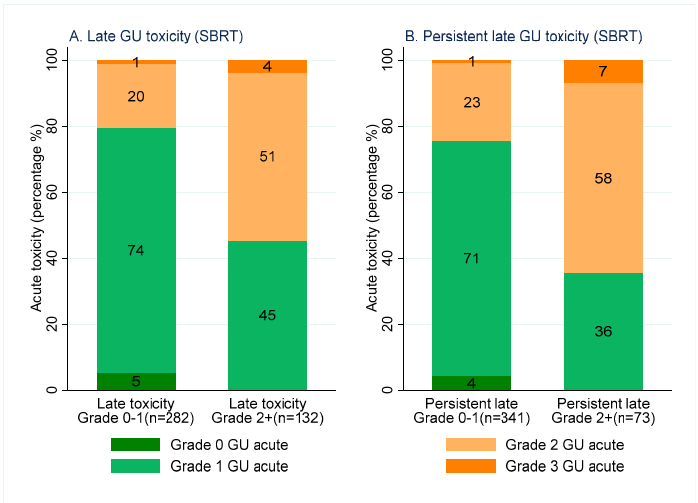
Figure 1. Stacked bar graph: maximum grade CTCAE acute GU toxicity experienced for patients with Grade 0–1 (left of each figure) and Grade 2+ (right of each figure) late GU toxicity following SBRT (left). Maximum grade CTCAE acute GU toxicity experienced by patients with grade 0–1 (left of each figure) and grade 2+ (right of each figure) persistent late GU toxicity following SBRT (right).